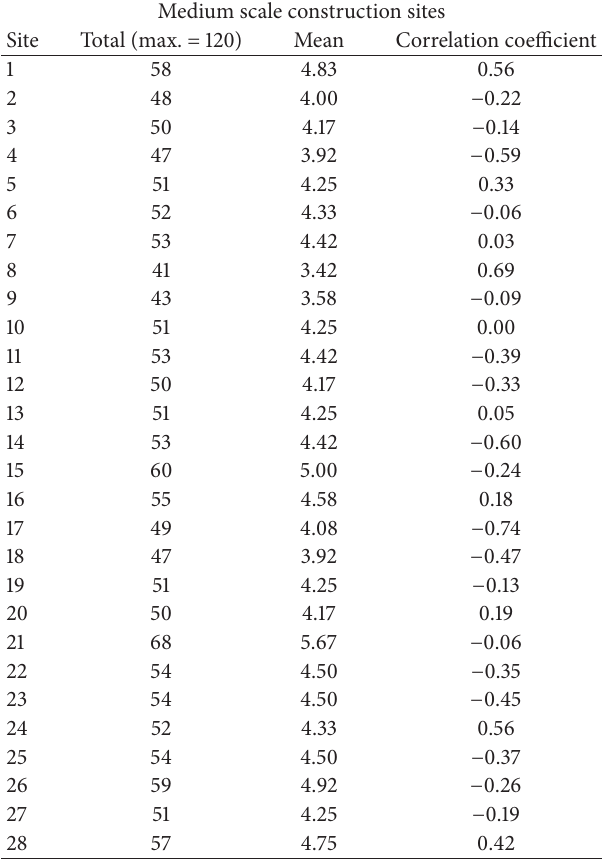
Table 4: Points obtained by medium scale construction.